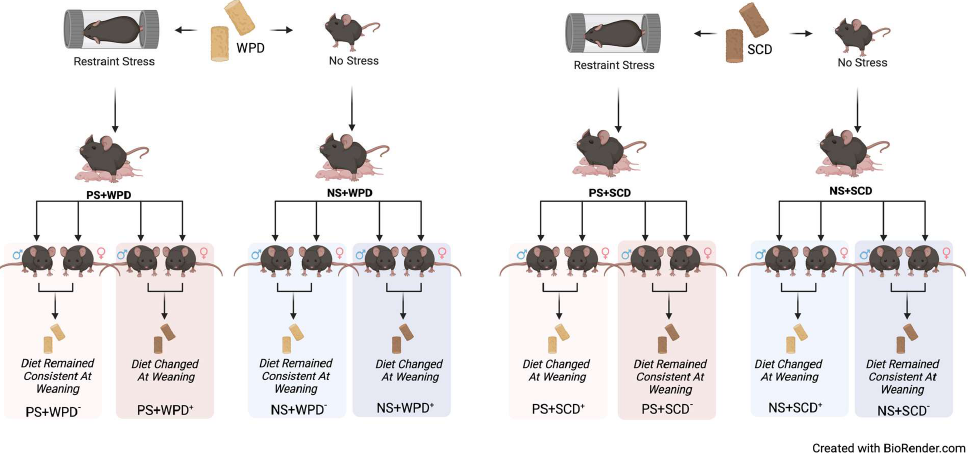
Figure 2. Graphic representation of experimental groups. WPD: Western-pattern diet; SCD: standard chow diet; PS: Prenatal Stress; NS: No Stress; ( − ) indicates no diet change at weaning; (+) indicates diet change at weaning. Figure created with Biorender.com. Dams in the WPD groups (stress n = 12, no stress n = 12) had their diet changed from SCD (Laboratory Rodent Diet 5001, LabDiet, St. Louis, MO, USA) to WPD (D12079B, Re- search Diets, New Brunswick, NJ, USA; Figure 3) on estimated gestation day (GD) 14 (ac- tual Mean GD = 13.20, SD = 1.27). Dams who were assigned to the SCD groups (stress n = 12, no stress n = 13) had no change in their diet. Pups were weaned on postnatal day (PND) 21. Half of each litter was randomly as- signed to a SCD and the other half to a WPD. Pups were housed with same-sex/same-diet siblings. Figure 3. Macronutrient kcal/gram % of experimental (WPD) and control (SCD) diets. WPD = west- ern pattern diet; SCD = standard chow diet. 2.3. Maternal Behavior Home-cage activity was used as a proxy for time dams spent in the nest, with higher activity used as an indication of dams spending less time in the nest with their pups. Dam activity levels were monitored continuously from parturition for approximately 24 h (the beginning of the first light cycle after parturition until the start of the second light cycle after parturition) using an automated monitoring system that recorded the number of in- frared beam breaks per minute (VitalView Animal Monitoring Software, Version 5.0). Pup retrieval was measured in the first 24 h after parturition. The dam was removed from the home cage for 2 min. During this time, one pup was removed from the nest and